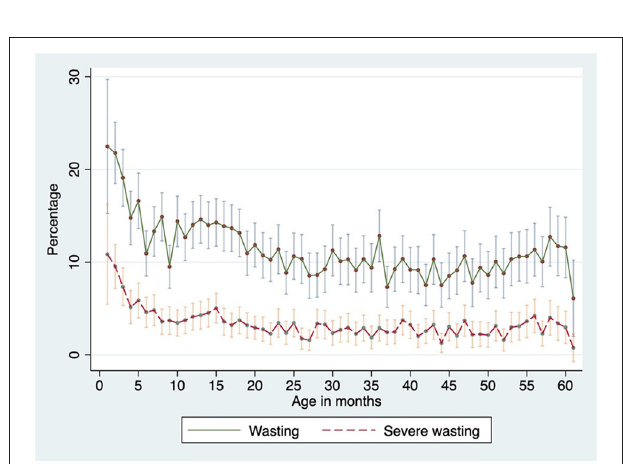
FIGURE 5 | Prevalence of wasting over children’s age in 2019. Source: Own elaboration based on Caritas Venezuela data. 95% confidence intervals. Wasting was defined according to the 2006 WHO growth